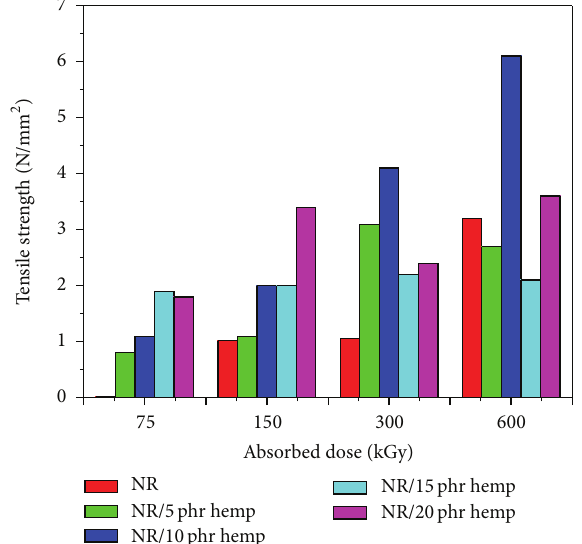
Figure 6: Tearing strength variation as a function of hemp amount and irradiation